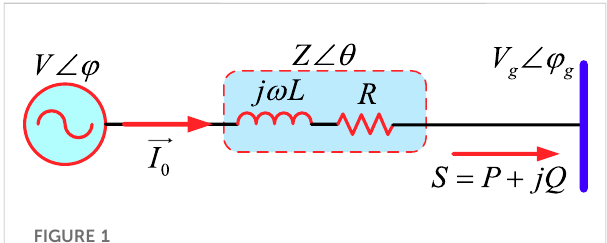
FIGURE 1 Equivalent physical circuit diagram of the grid-connected